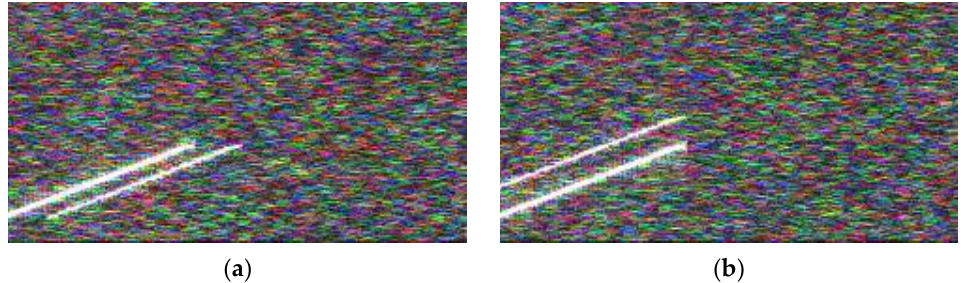
Figure 8. Multi-pulse original signal plus jamming time–frequency diagram fusion under low JNR. ( a ) RFTJ + original signal. ( b ) VFTJ + original signal.